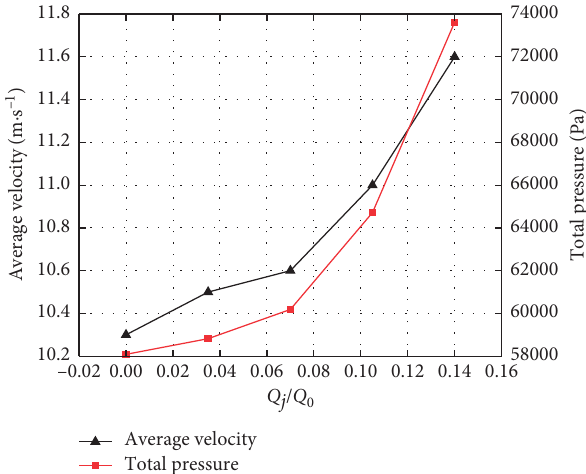
Figure 8: Variations of average nozzle velocity and total pressure under different jet flow